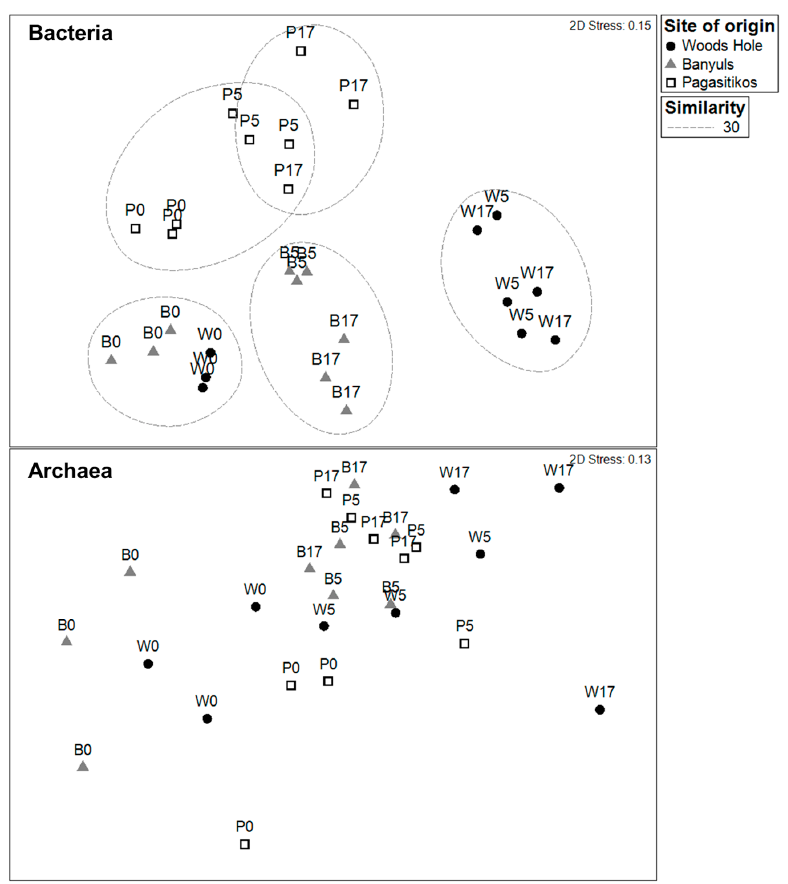
Figure 3. Multidimensional Scaling ordination (MDS) showing the similarity of samples based on the Bray Curtis index on presence-absence Bacteria and Archaea OTU data. Symbols indicate the site that the inoculum originates from (B: Banyuls, P: Pagasitikos, and W: Woods Hole) whereas the labels indicate also the growth phase (day 0, day 5-exponential growth, day 17-stationary phase).